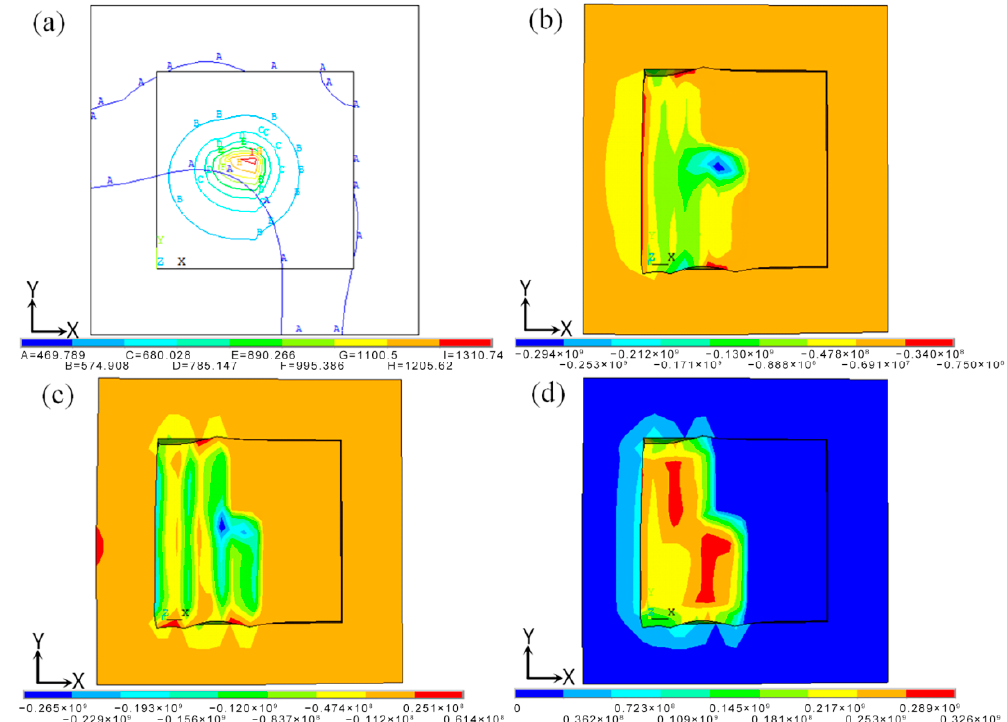
Figure 6. The isotherm temperature and stress fields during the selective laser melting (SLM) process. ( a ) The isotherm temperature field; ( b ) Tensile stress distribution; ( c ) Compressive stress distribution; ( d ) Equivalent stress distribution.